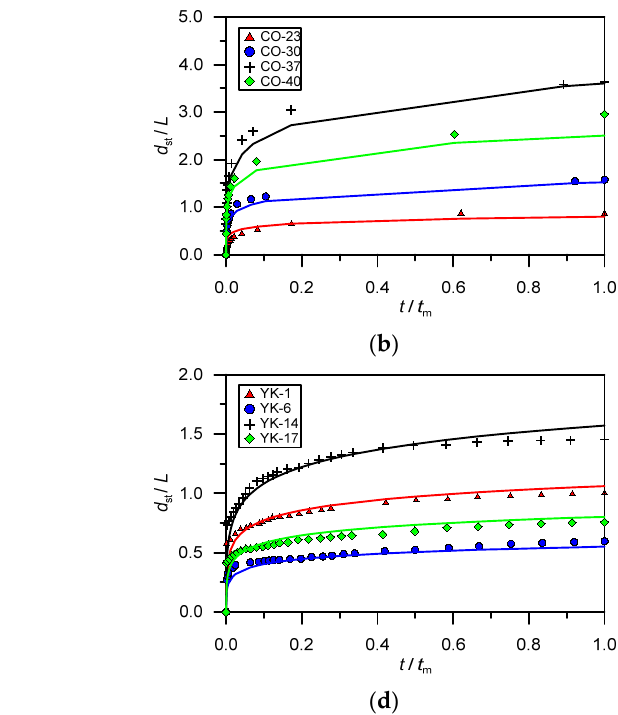
Figure 6. Comparison of temporal variation of scour depth between the proposed model and the experimental data of ( a ) Kwan [26], ( b ) Coleman et al. [18], ( c ) Dey and Barbhuiya [19], and ( d ) Yanmaz and Kose [20].